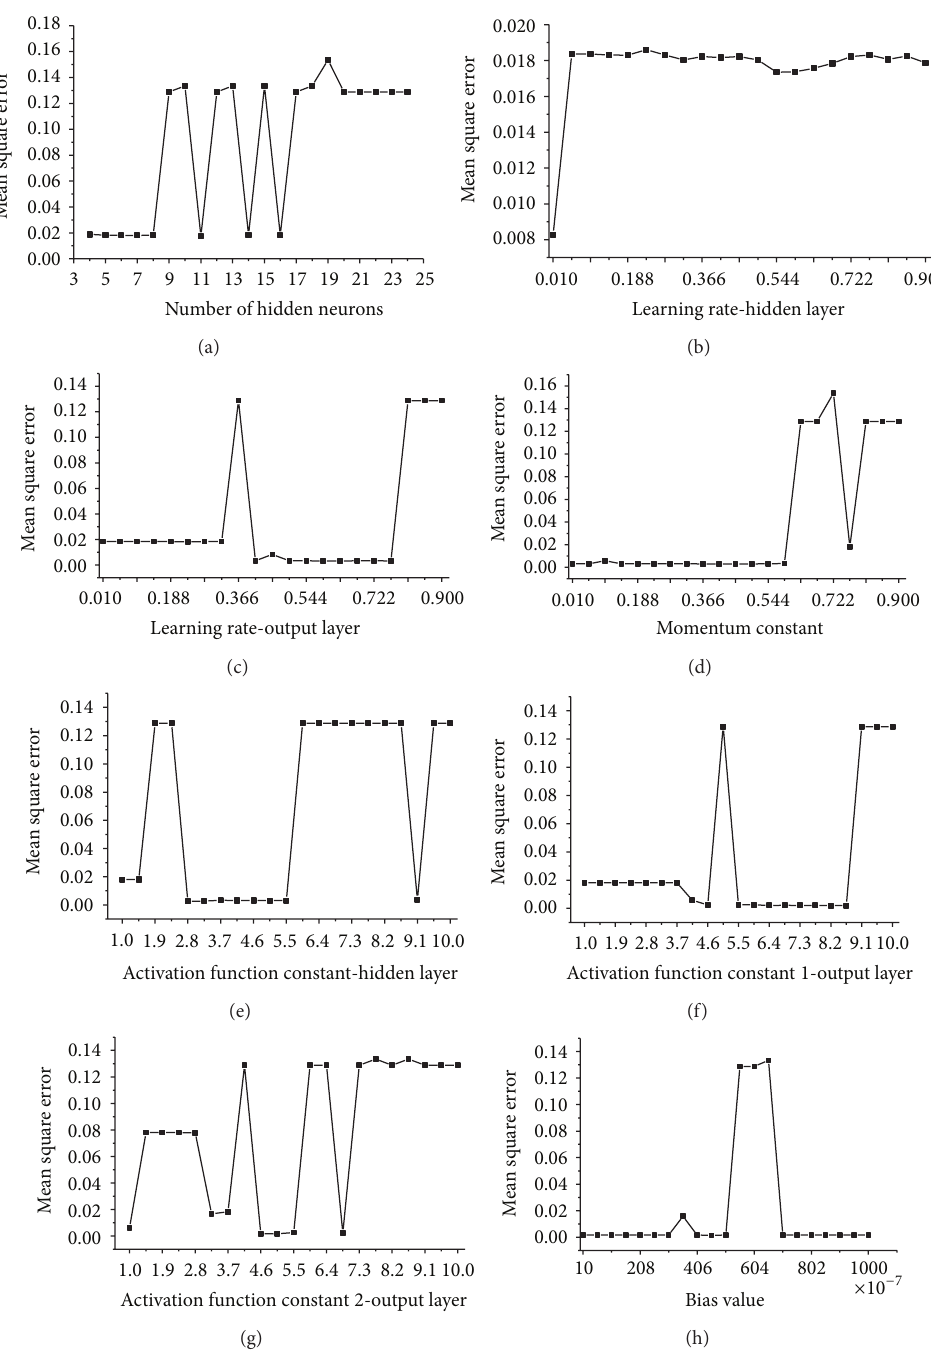
Figure 3: Results of parametric study to determine the optimal neural network parameters: (a) error versus number of neurons in the hidden layer, (b) error versus learning rate-hidden layer, (c) error versus learning rate-output layer, (d) error versus momentum constant, (e) error versus activation function constant-hidden layer, (f) error versus activation function constant 1-output layer, (g) error versus activation function constant 2-output layer, and (h) error versus bias